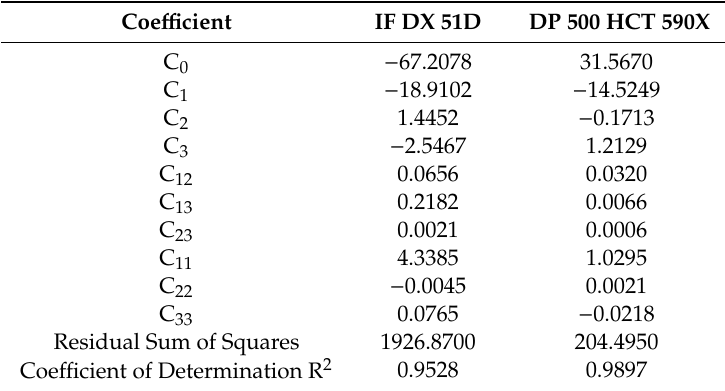
Table 5. Summary of regression analysis results.